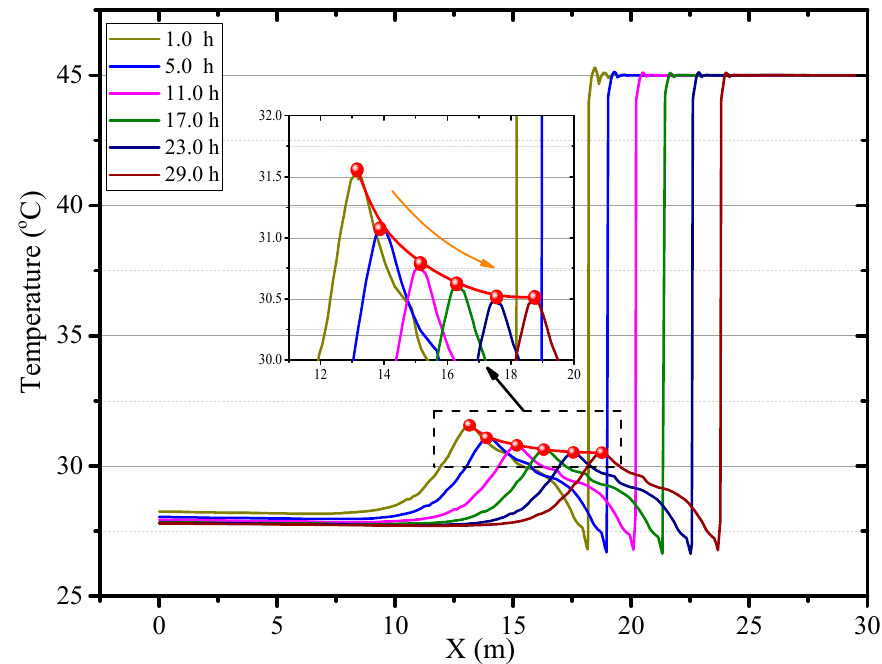
Figure 5. Air temperature in central axis of roadway ( Z = 0.5) at different times.